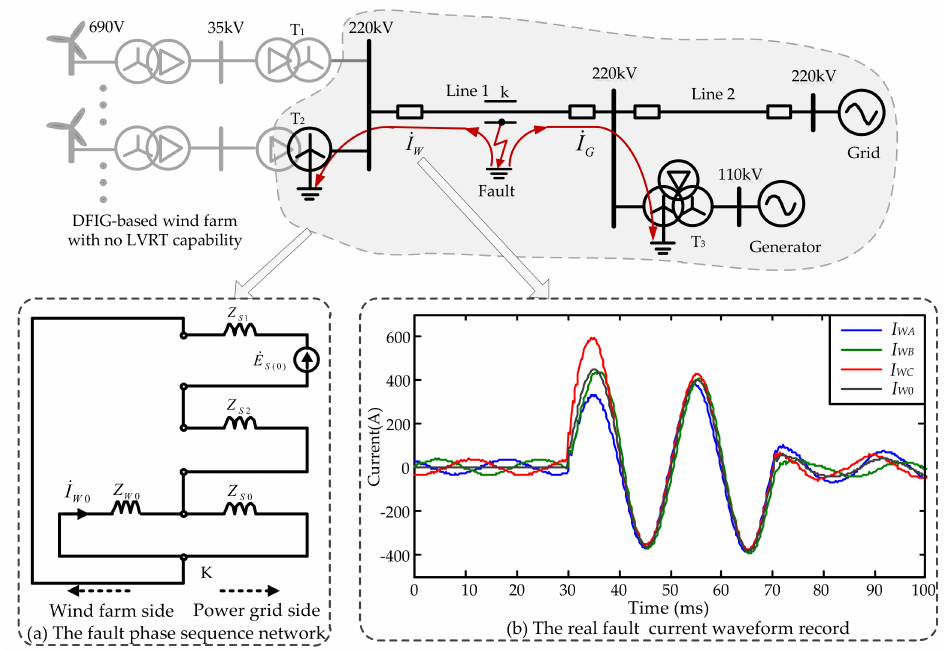
Figure 4. The real fault case when a phase C ground fault occurs on the transmission line connected to DFIG-based wind farm without low voltage ride through (LVRT)